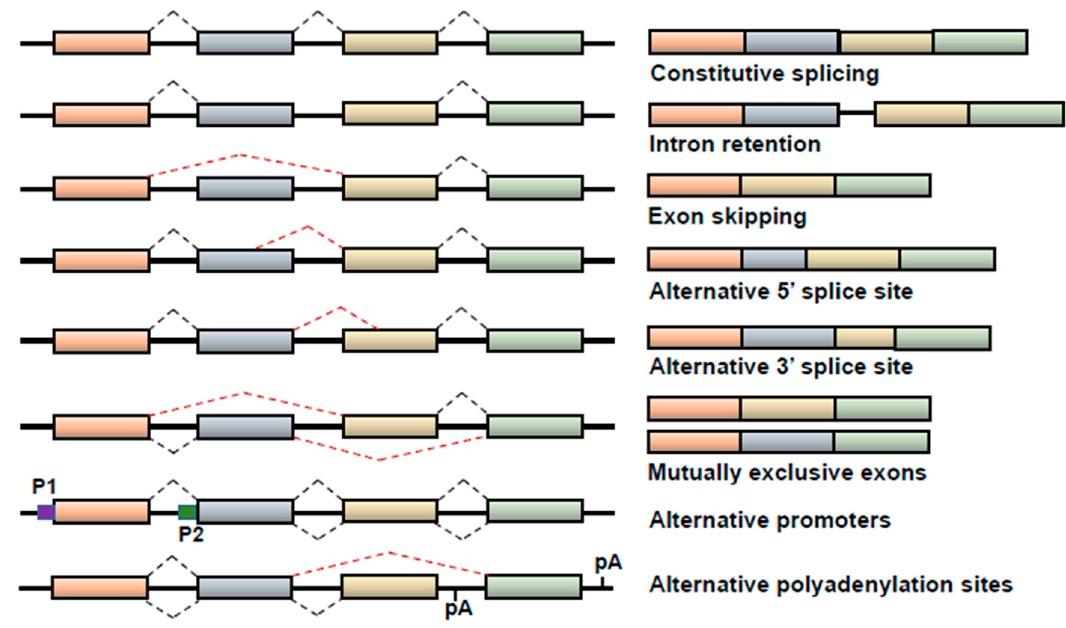
Figure 1. Different modes of alternative RNA splicing. Different modes of alternative splicing (AS), including constitutive splicing, intron retention, exon skipping, alternative splice site selection (5’ and 3’), mutually exclusive splicing, alternative promoter selection and alternative polyadenylation sites [19,20]. The pre-mRNAs are shown on the left panel, and the mature mRNA variants following AS are shown on the right panel.